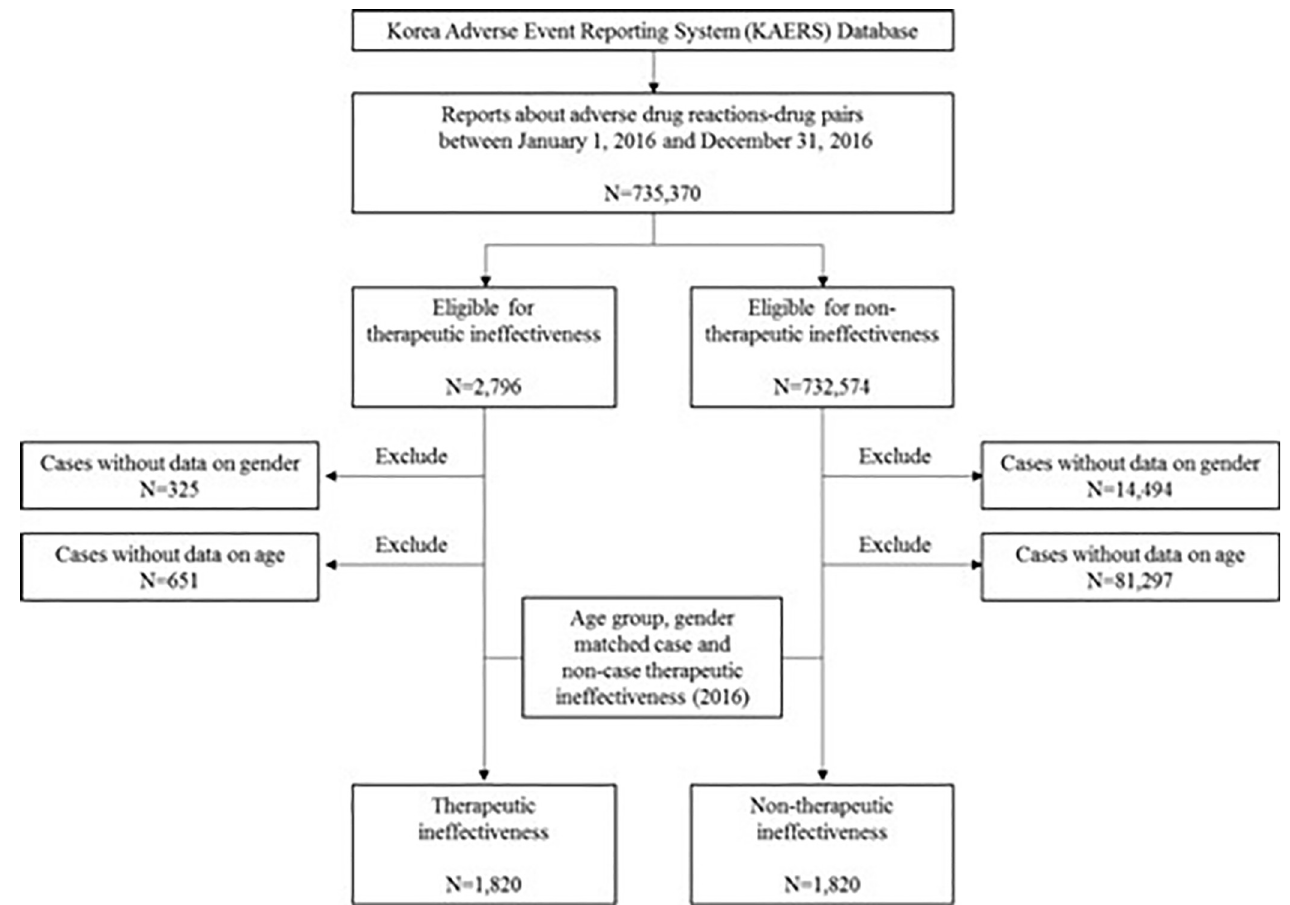
Fig 2. Therapeutic and non-therapeutic ineffectiveness searching process in the KAERS database from